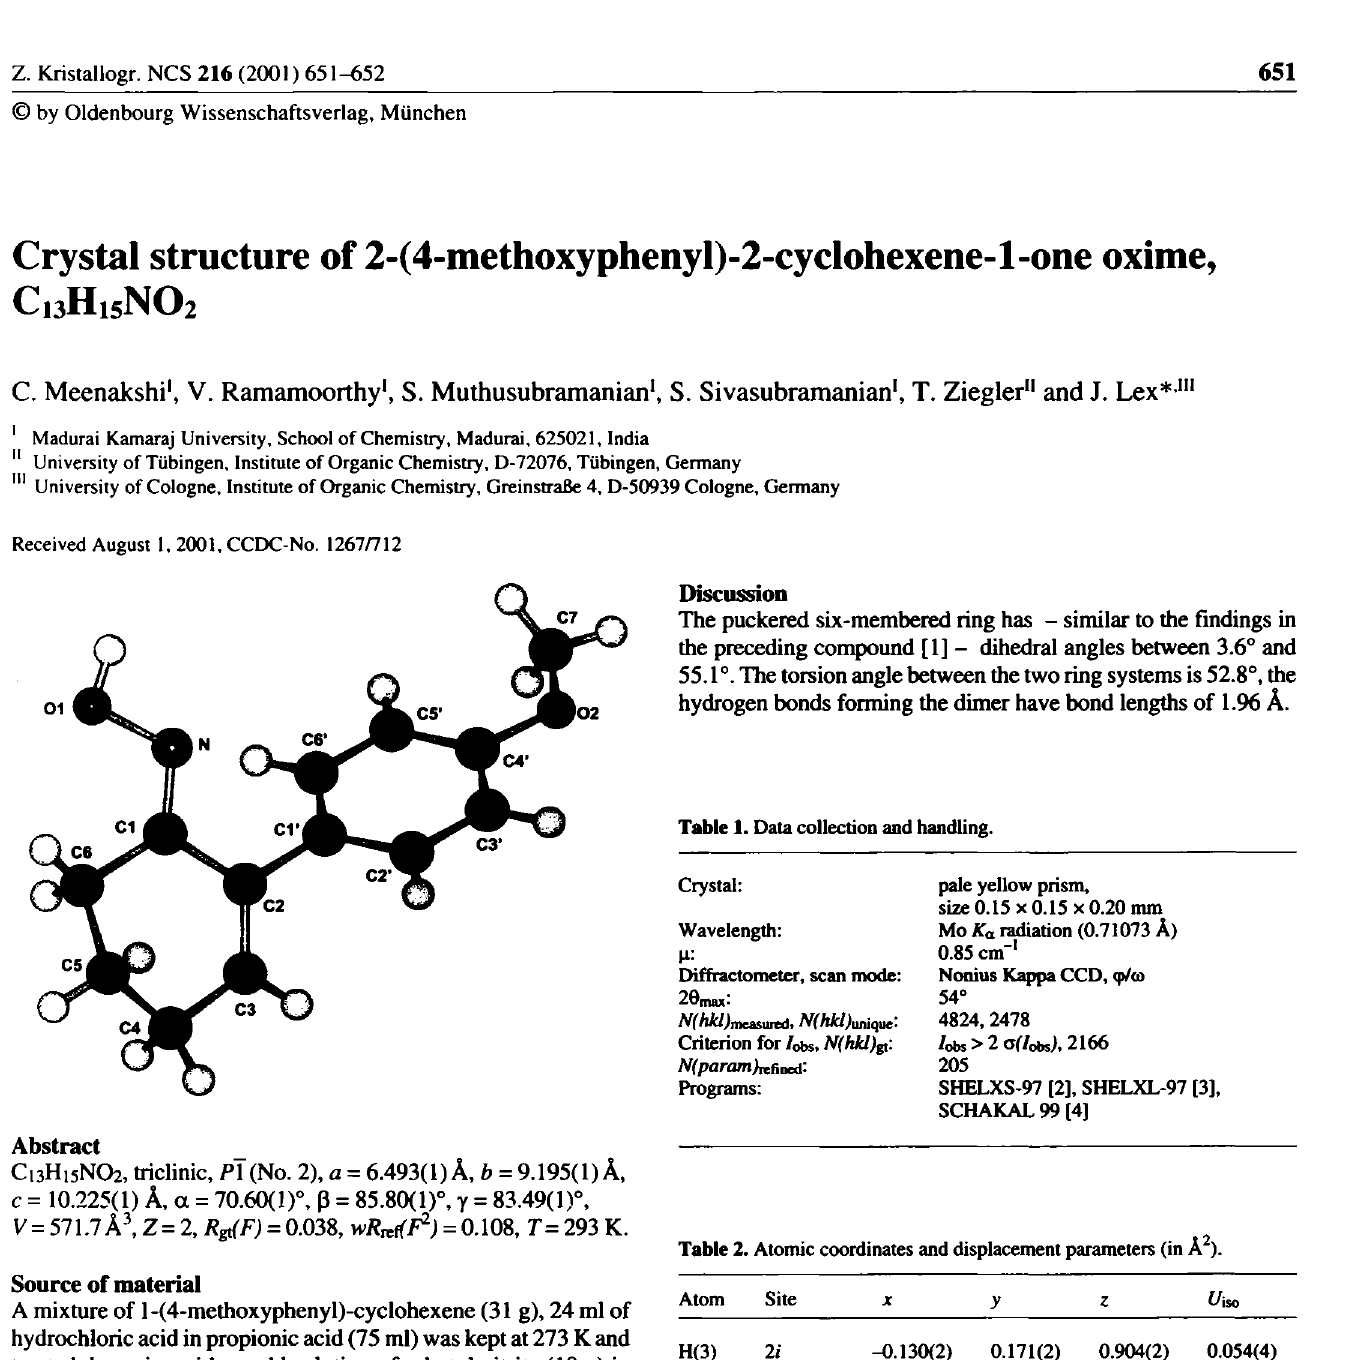
Table 2. Atomic coordinates and displacement parameters (in A 2